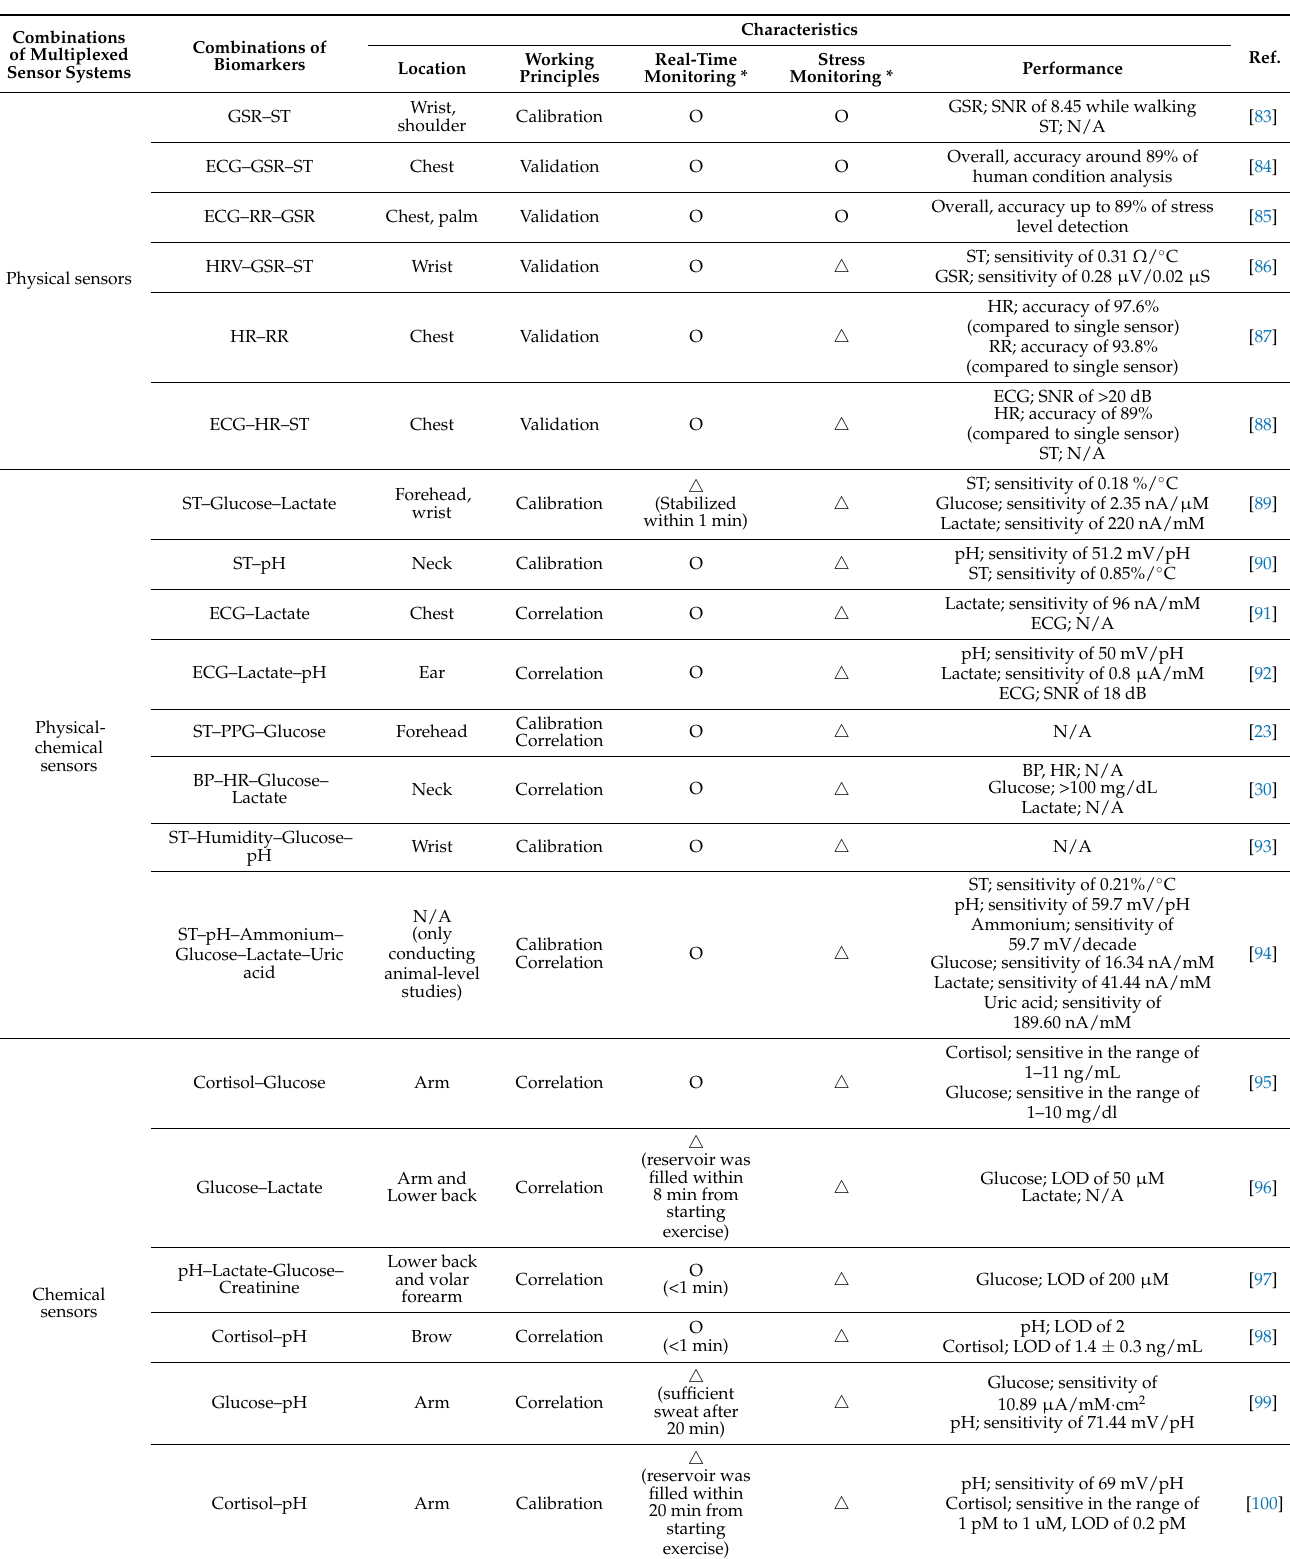
Table 2. Multiplexed sensor systems and their